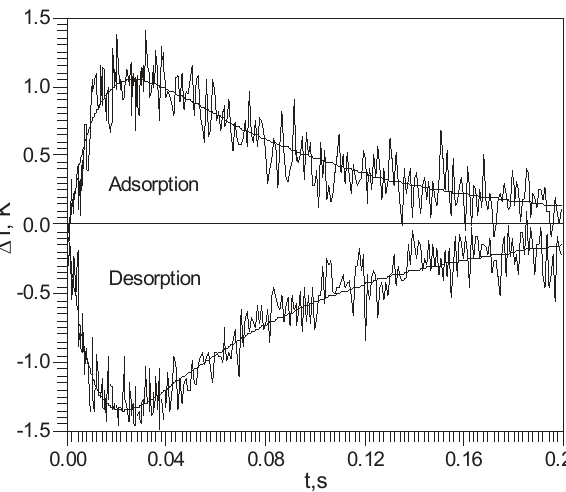
Figure 2: Temperature change when measuring the adsorption and CO desorption time 2